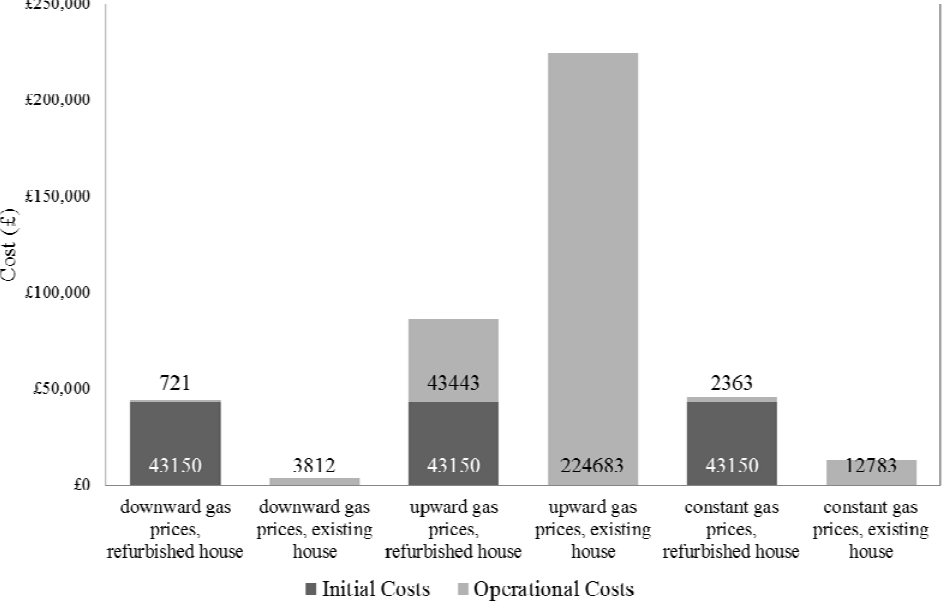
Figure 13. Whole Life Cycle Cost (WLCC) of the pre and post refurbished house for current and future London weather data over 40 years for different gas price